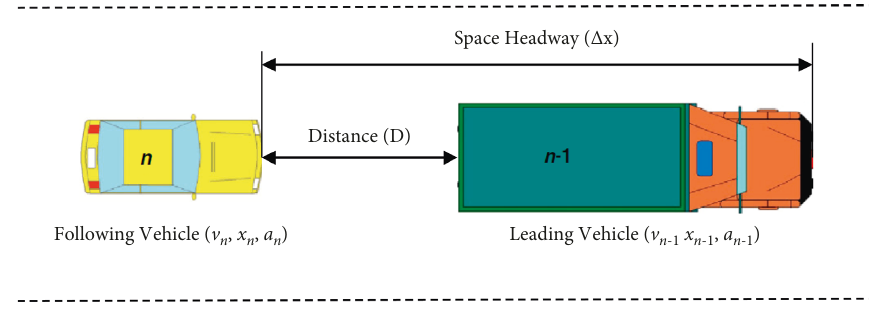
Figure 1: The car-following model and its variables. Table 1: A typical car-following process with measurement data.